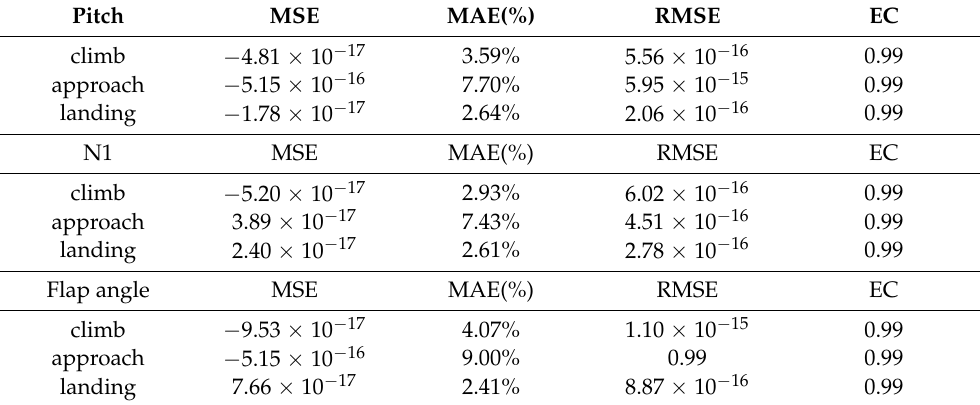
Table 3. Error index of missing data